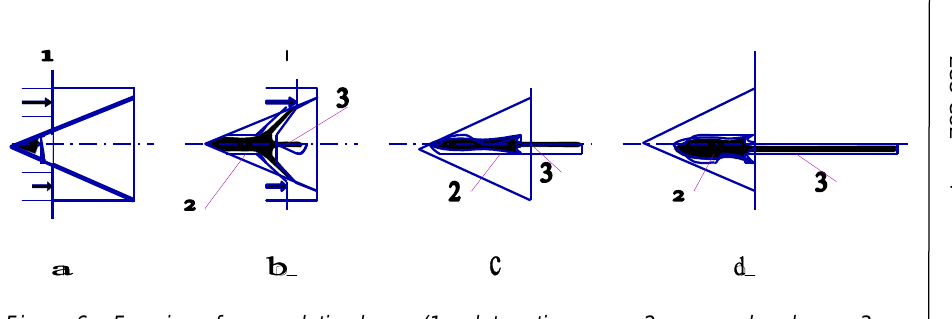
Figure 6 – Forming of a cumulative beam (1 – detonation wave; 2 – secondary beam; 3 – primary beam)